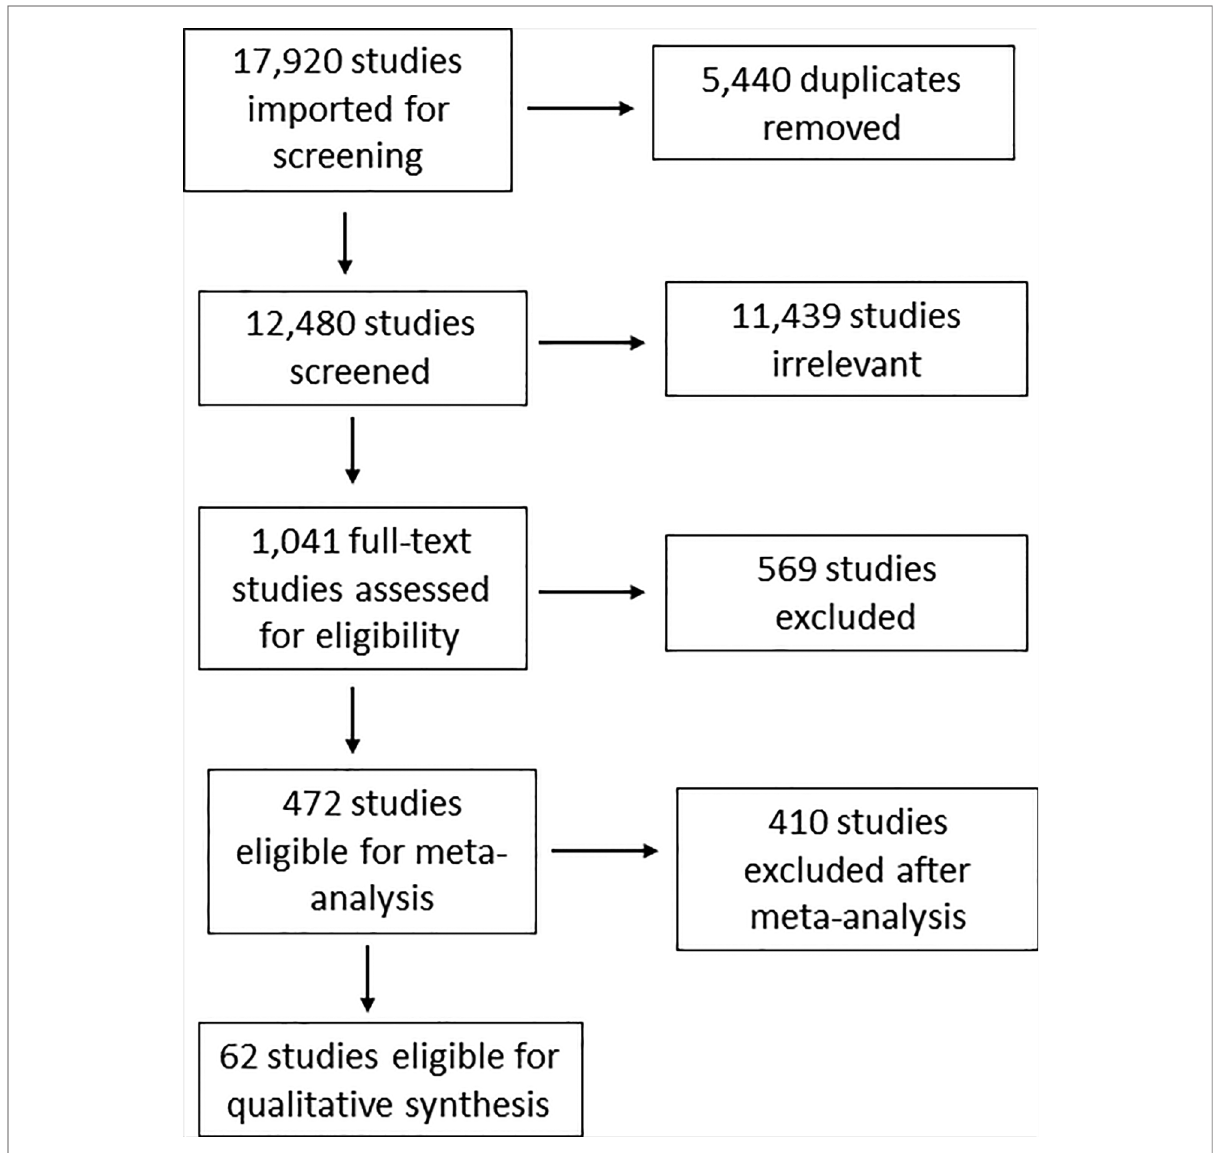
FIGURE 1 PRISMA fl owchart delineating the process used to conduct the systematic